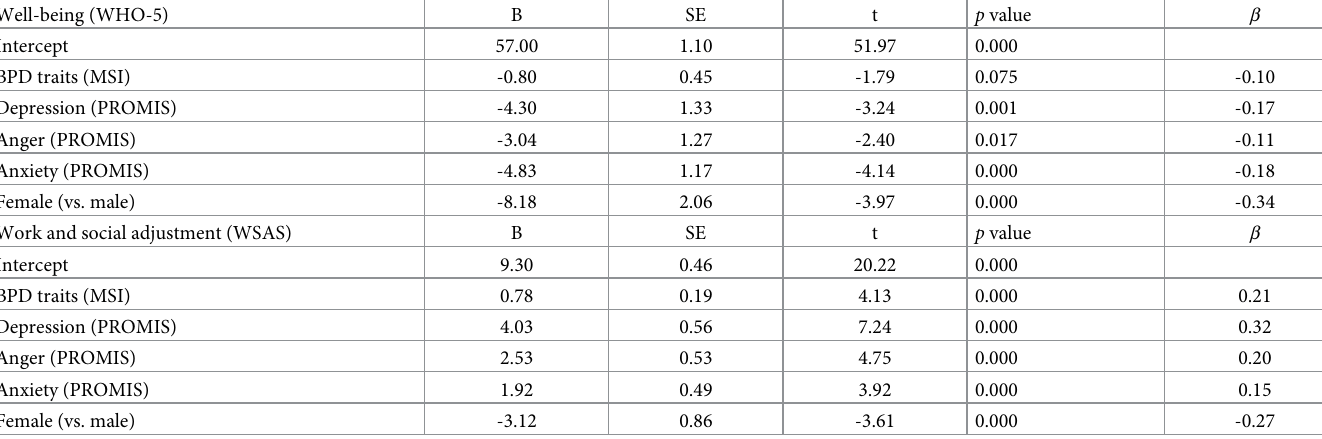
Table 3. Multivariable prediction of well-being and work and social adjustment from symptoms of borderline personality disorder, depression, anger, and anxiety (n = 471). Well-being (WHO-5) B